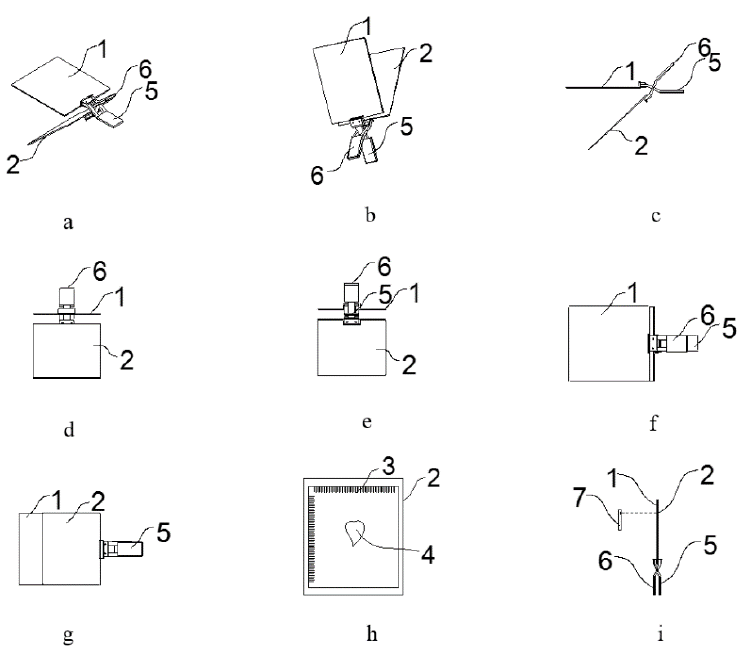
Figure 1. The leaf measuring device. ( a ) Perspective structural view of one of the angles; ( b ) perspective structural view of another angle; ( c ) front view; ( d ) left side view; ( e ) right side view; ( f ) plane view; ( g ) bottom view; ( h ) structural view of the leaf fixing device in which the correction plate is fixed to the lower splint; and ( i ) schematic diagram of the image acquisition system. ( 1 ) upper splint; ( 2 ) lower splint; ( 3 ) correction plate; ( 4 ) measured leaf; ( 5 ) first handle; ( 6 ) second handle; and ( 7 ) mobile terminal.